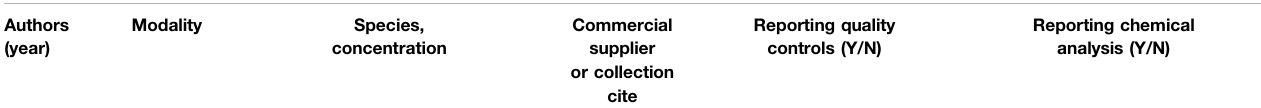
TABLE 3 | ( Continued ) Information of herbal medicine or herb compounds in the